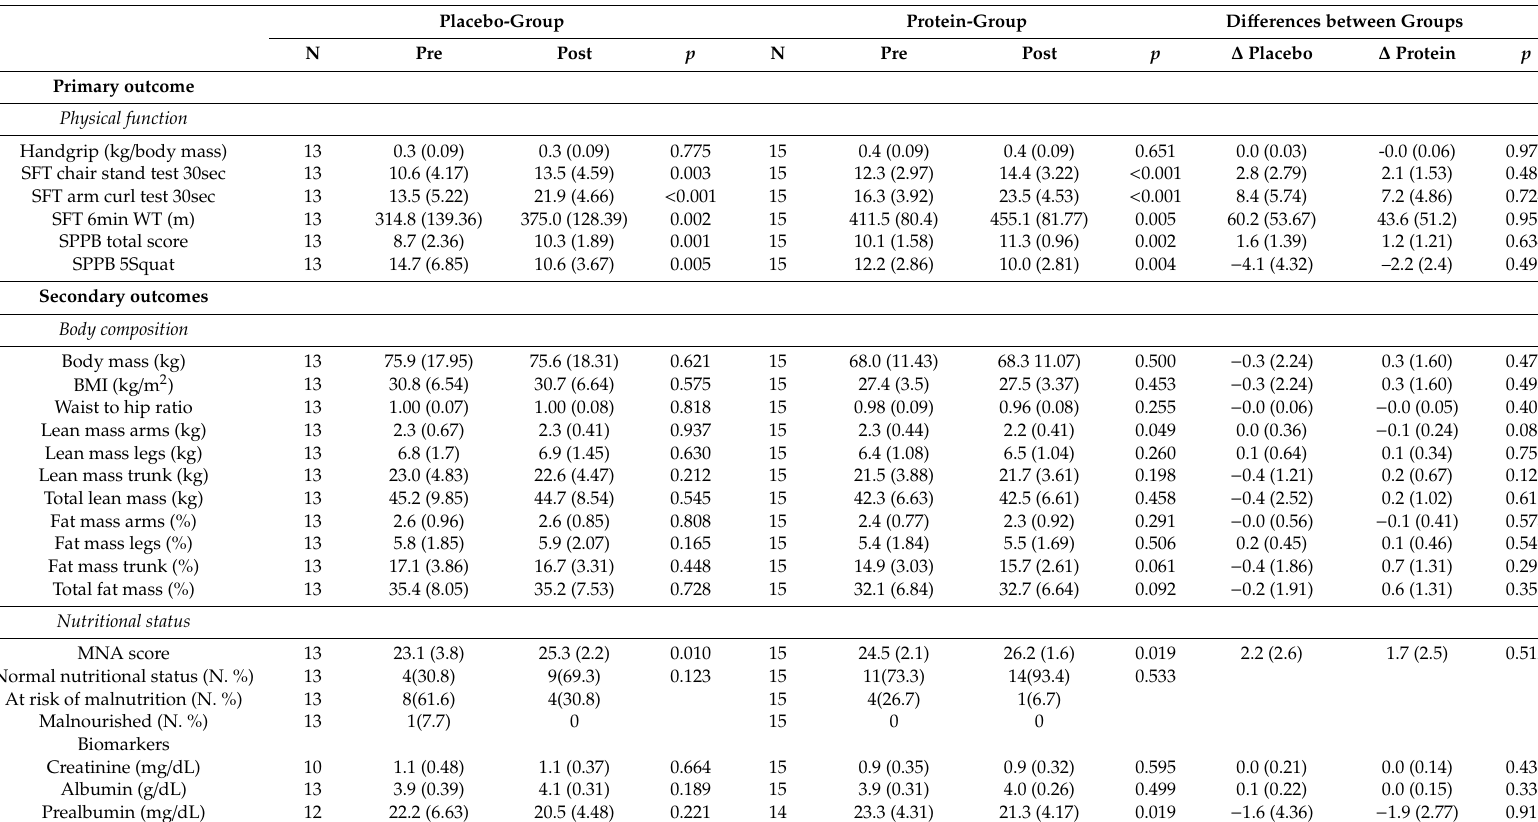
Table 3. Body composition, nutritional status and physical function in elderly patients before (Pre) and after (Post) their participation in the resistance exercise intervention program plus protein supplementation (Protein-group) or placebo (placebo-group) (analyses per